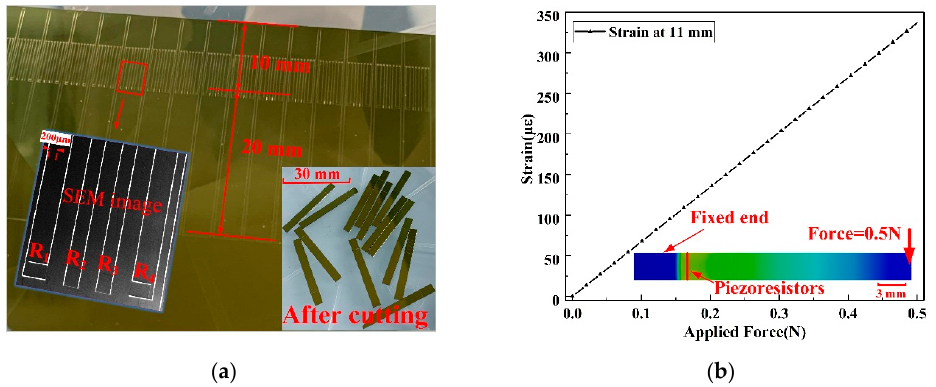
Figure 1. ( a ) Cantilever beam based on p-type 4H-SiC piezoresistors ( R 1 , R 4 longitudinal piezoresistors, R 2 , R 3 transverse piezoresistors); ( b ) Finite element analysis (FEA) shows a